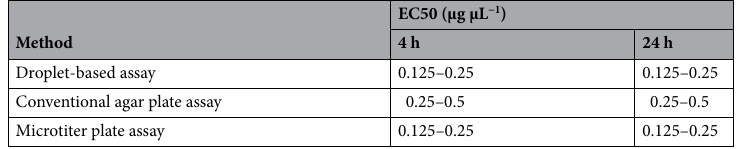
Table 1. Mean EC50 values (effective concentration that inhibited spore germination by 50%) for Alternaria alternata obtained from in vitro assessment of kunshi after 4 h and 24 h of incubation at 26 ± 1